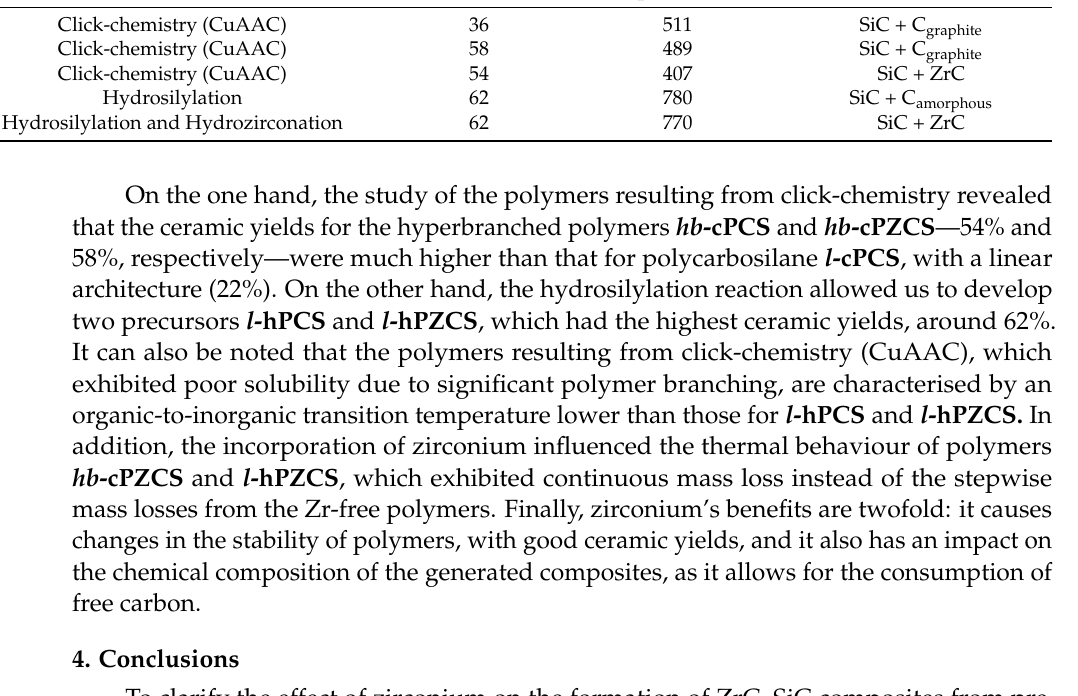
cPCS , Figure S7: TG profiles of l -cPCS and l -hPCS and DATD of l -hPCS , Figure S8: TG profile of ZrCp 2 Cl 2 , Figure S9: TG profiles of hb -cPCS and hb -cPZCS and DSC of hb -cPZCS , Figure S10: Mass spectrometry of the gaseous species released during the pyrolysis of l -hPCS , Figure S11: TG profiles of l -hPCS and l -hPZCS and DATD of hb -cPZCS , Figure S12: TG profile of ZrCp 2 H 2 ,